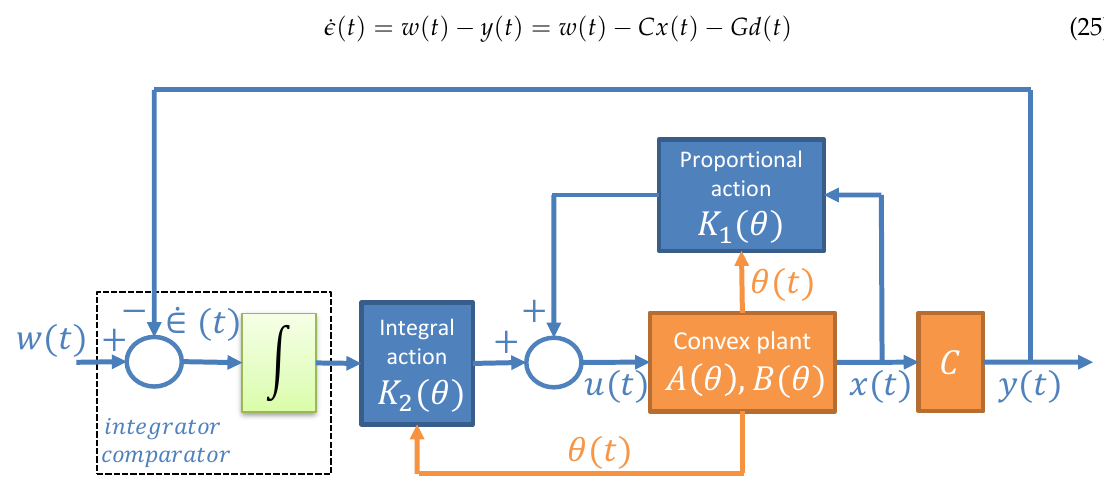
Figure 3. Convex tracking controller